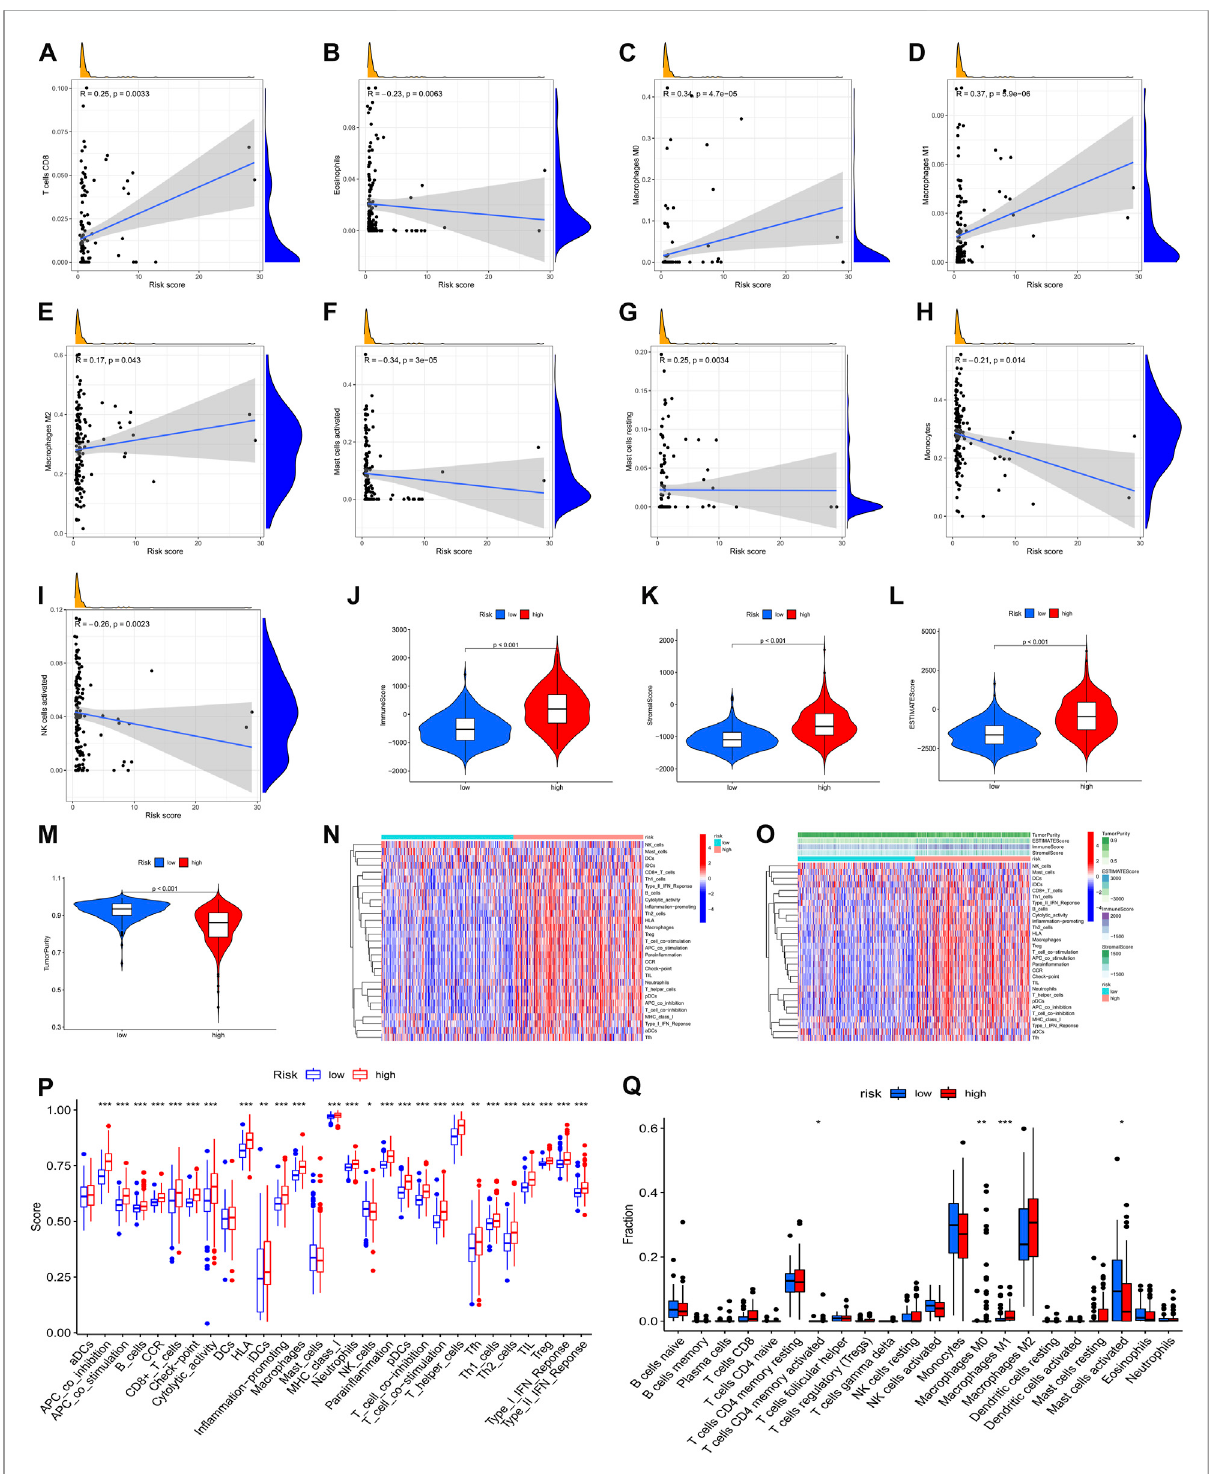
FIGURE 9 Acorrelationwasobservedbetweenthein fi ltrationstatusofimmunecellsandanAS-basedpredictivesignaturebasedonthem6Amethylation modulator. (A) . The correlation between the signature and CD8 + T cells. (B) . The signature is correlated with eosinophils. (C) . The correlation between the signature and M0 macrophages. (D) . The correlation between the signature and M1 macrophages. (E) . The correlation between the signature with M2 macrophages. (F) . The correlation between the signature and activated mast cells. (G) . Relationship between the signature andresting mastcells. (H) .Relationshipbetween thesignatureandmonocytes. (I) .Relationship between thesignatureandactivated NKcells. (J – M) .